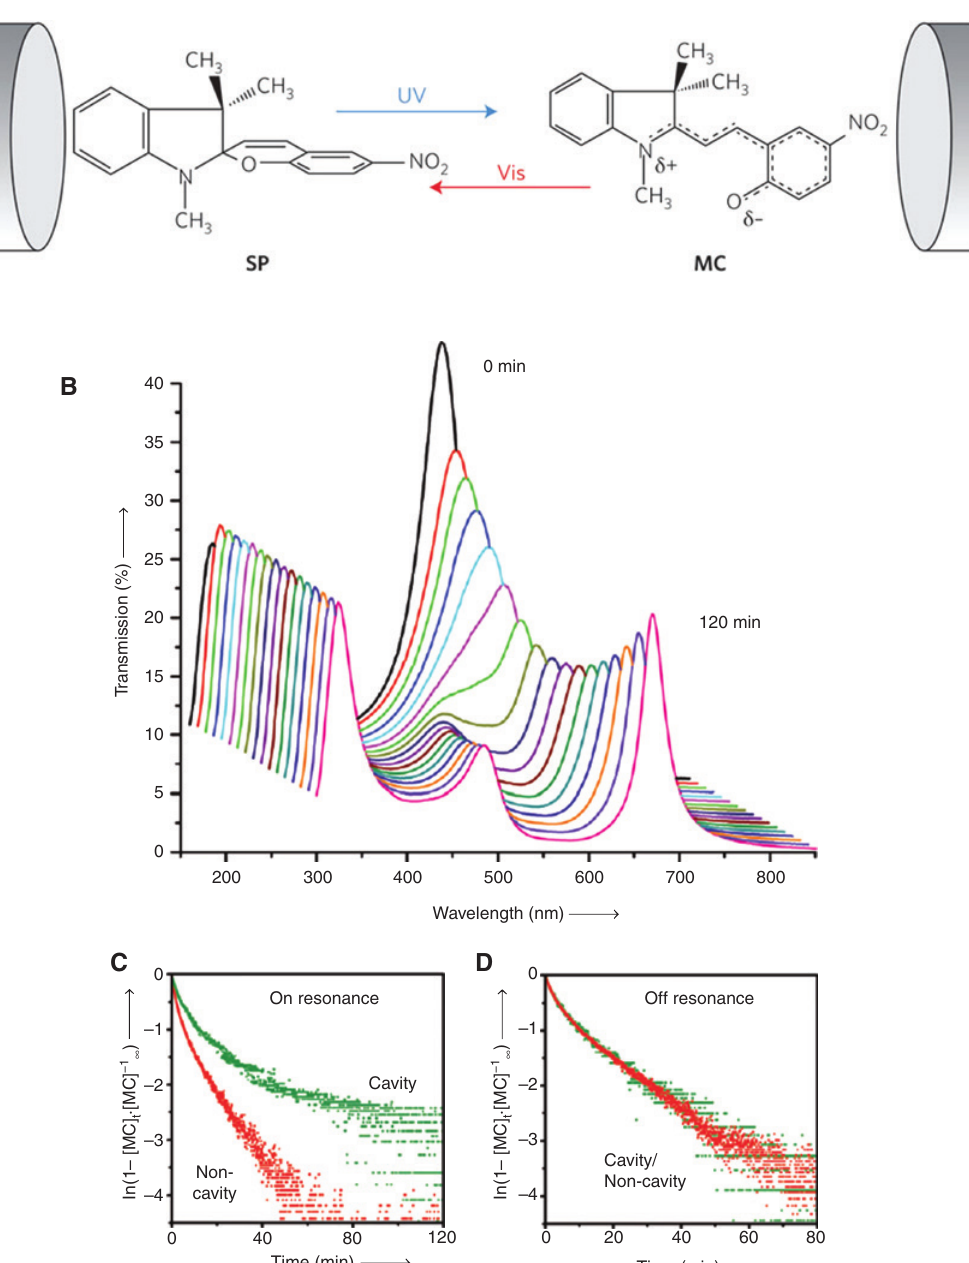
Figure 6: Schematics of the mechanism of phonochromic conversion and related evidence. (A) Schematic of the conversion of phonochromic between spiropyran (SPI) [44] and merocyanine (MC) in an optical cavity [111]. (B) Spec- trum of transmission of the coupled system in the cavity. Noted that the initial mode of Fabry-Perot at 560 nm with the SPI to MC photo- reaction proceeds to splitting and two new modes formed. (C) Measurement of the absorbance of MC. The red and green lines represent the uncoupled (bare molecules) and coupled system, respectively. For this case, the resonant frequency of the cavity is tuned to match the absorption frequency of MC at 560 nm, and the difference in the rate of increase of the coupling strength increases gradually. (D) In con- trast, the rate of photoisomerization is identical to the sample of noncavity , j 〉 and the cavity is in the vacuum field | . h 〉